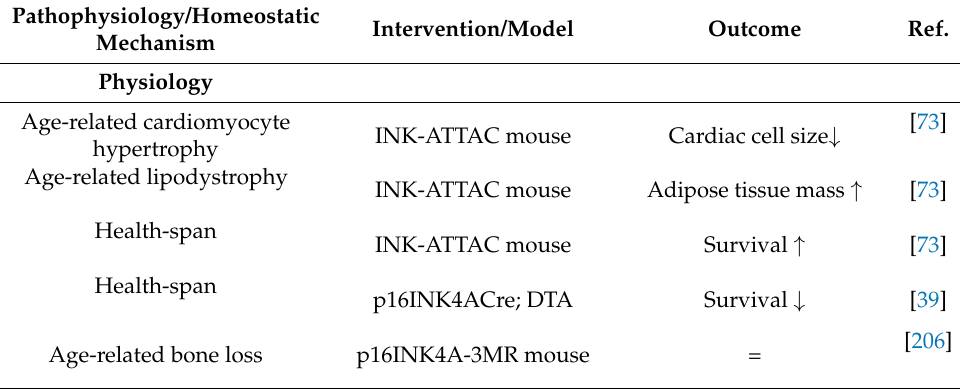
Table 2. Major phenotypes associated with p16INK4A, p14ARF/p19ARF, or p21 modifications in homeostasis and pathophysiology.